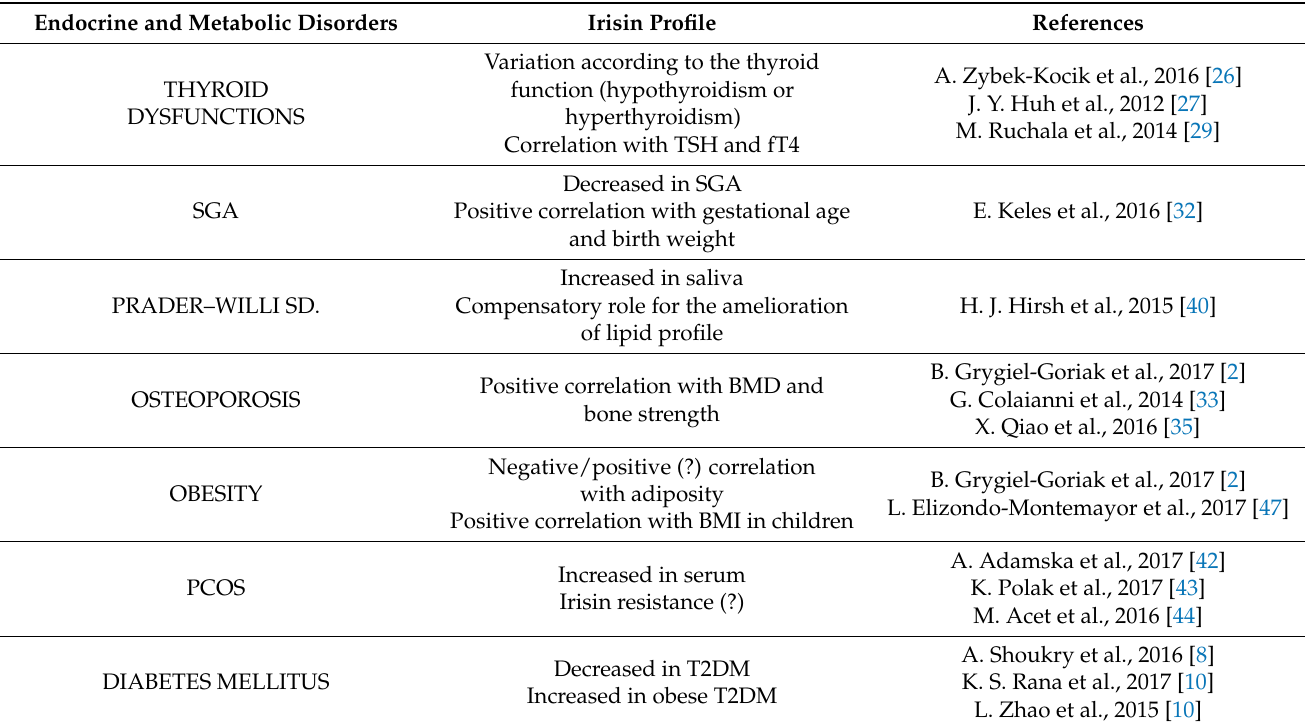
Table 1. Irisin profiles with respect to various endocrine and metabolic